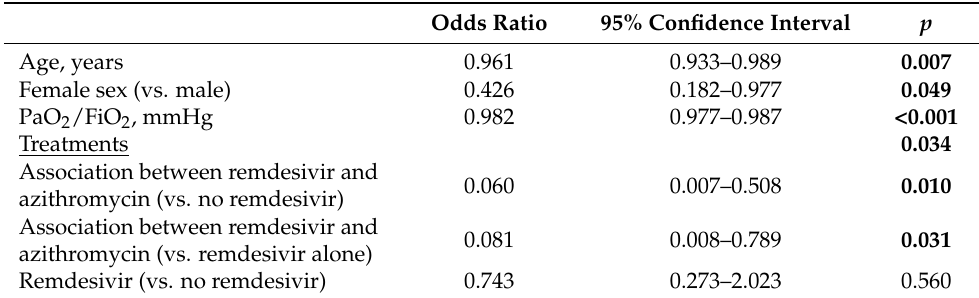
Table 5. Factors independently associated with ICU admission in the studied population on a stepwise logistic regression